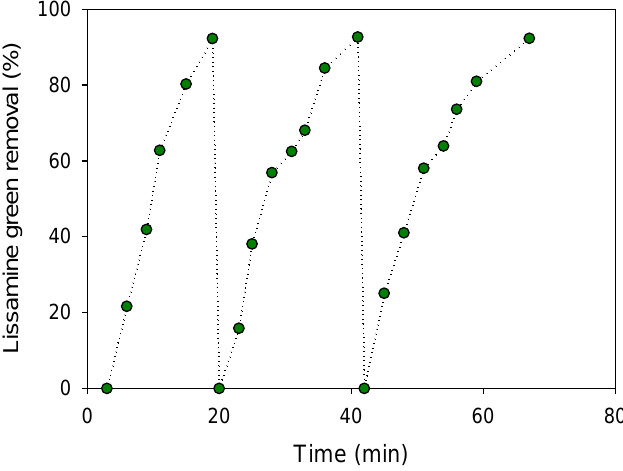
Figure 8. Reusability of catalyst in order of lissamine green removal at larger scale. Experimental conditions: [lissamine green] = 7.5 mg·L −1 , [PS] = 1 mM, [catalyst] = 30 g·L −1 , volume = 1.5 L.